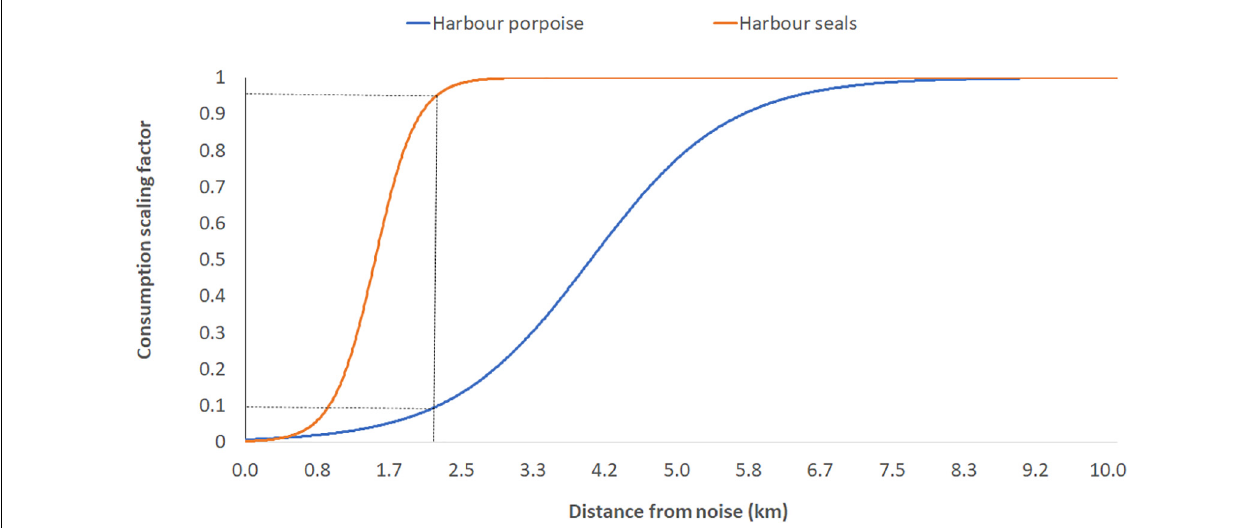
FIGURE 3 | Hypothetical Species distance response functions for harbor porpoise and harbor seals developed for the purposes of this study. The intercept between spatial distance and the species response functions determined the consumption rate scaling factor.